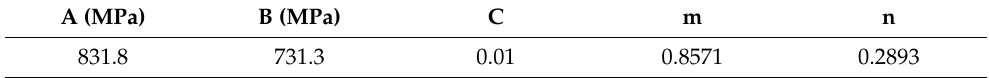
Table 4. Johnson–Cook constants for orthogonal machining of AerMet100 steel [30].